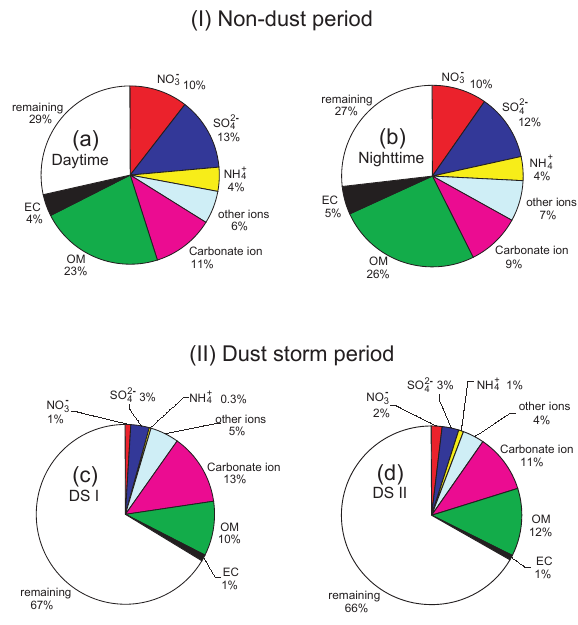
Fig. 5. Mass closure of PM 10 during the sampling periods (OM: organic matter = OC ×